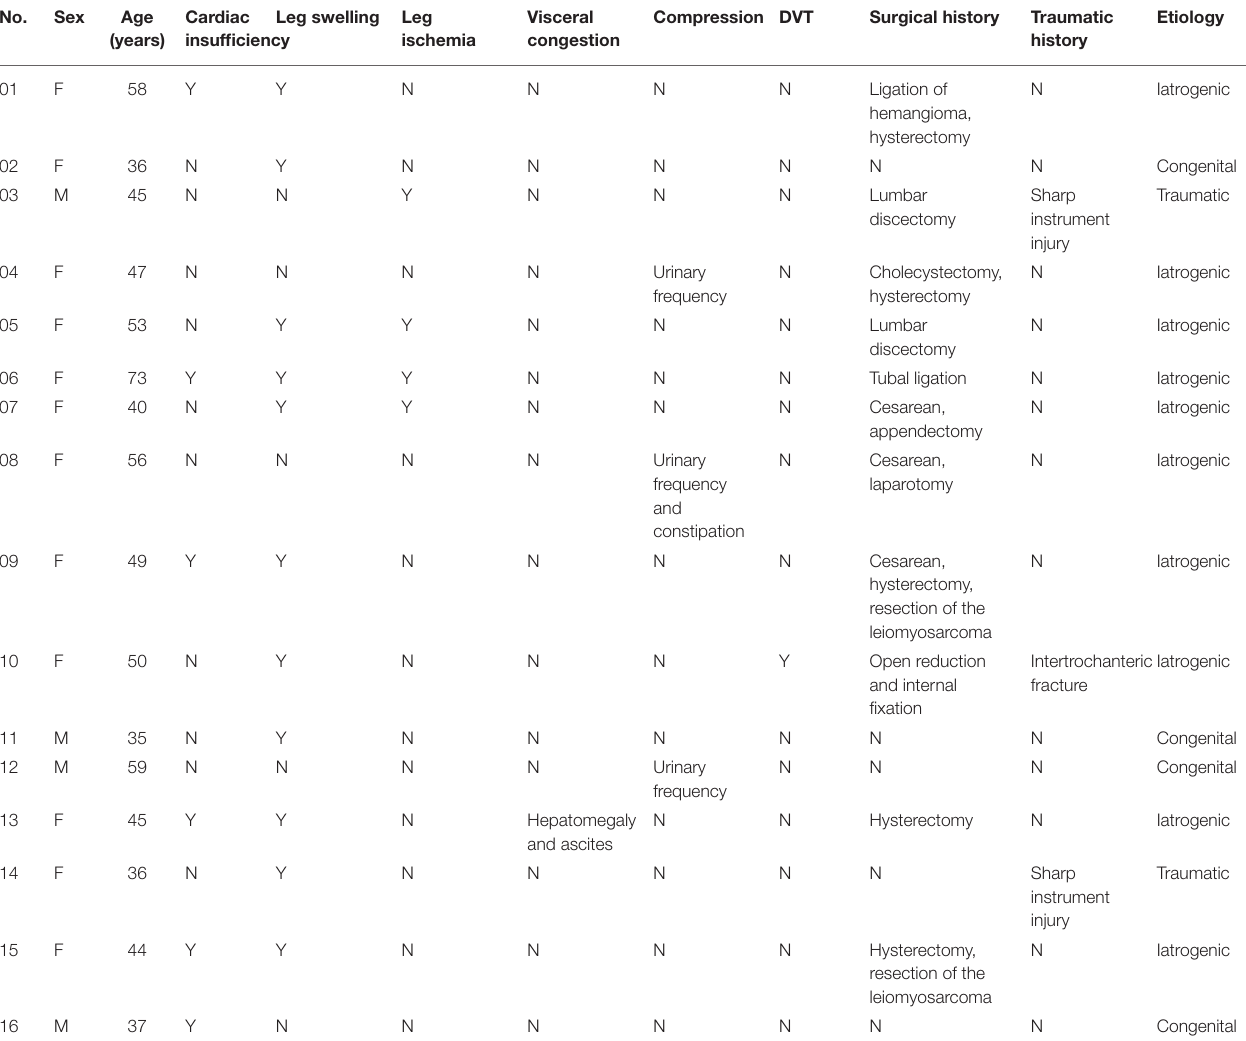
TABLE 1 | Demographics and clinical characteristics of patients with iliac arteriovenous fistulas (IAVFs). No. Sex Age Cardiac insufficiencyLeg swelling Leg (years)